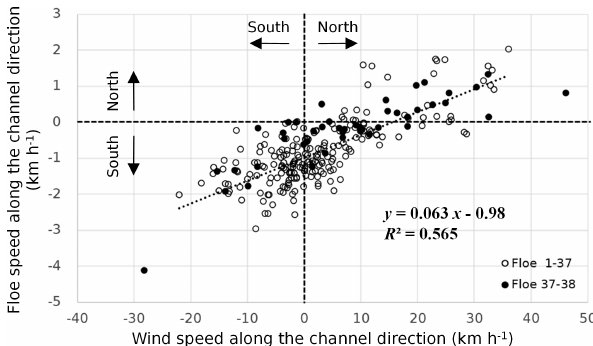
Figure 10. Scatter plot of wind versus ice floe speed components along the Robeson Channel direction. Positive and negative values pertain to wind or ice motion heading north or south, respectively. Data from 39 floes drifting within the Robeson Channel are shown. The open circles pertain to 37 ice floes that originated north of the Robeson Channel and then formed part of the drifted ice regime in the Robeson Channel (where many ice floes existed). The closed circles represent data from two floes that originated inside the Robe- son Channel and then drifted in the polynya formed after the ice arch was formed. The dashed line is the linear regression for the data of the 37